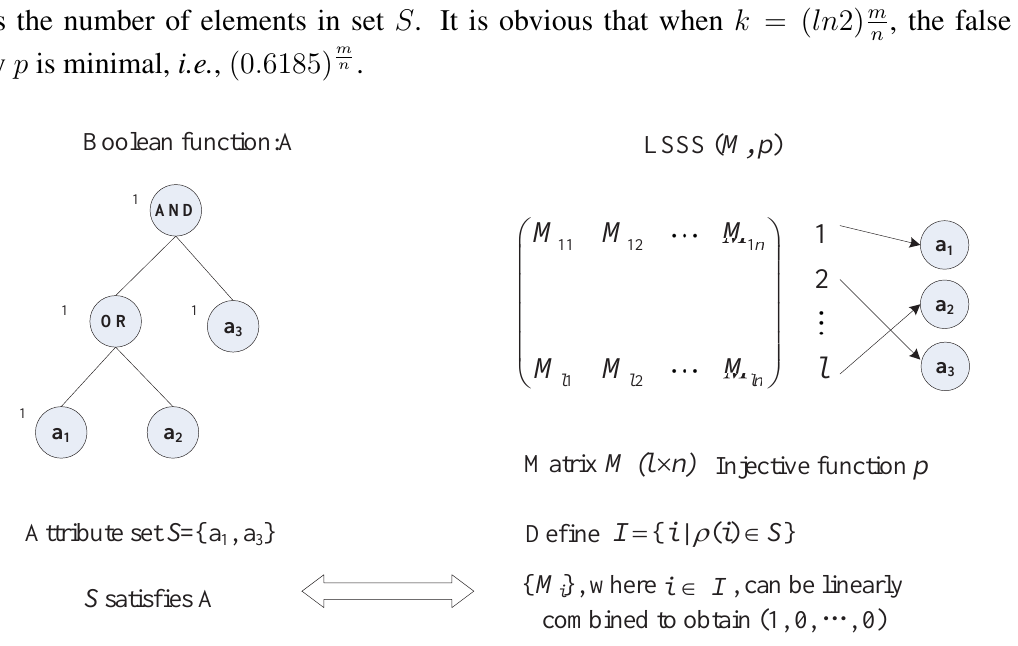
Figure 2. An attribute set satisfying a linear secret-sharing scheme